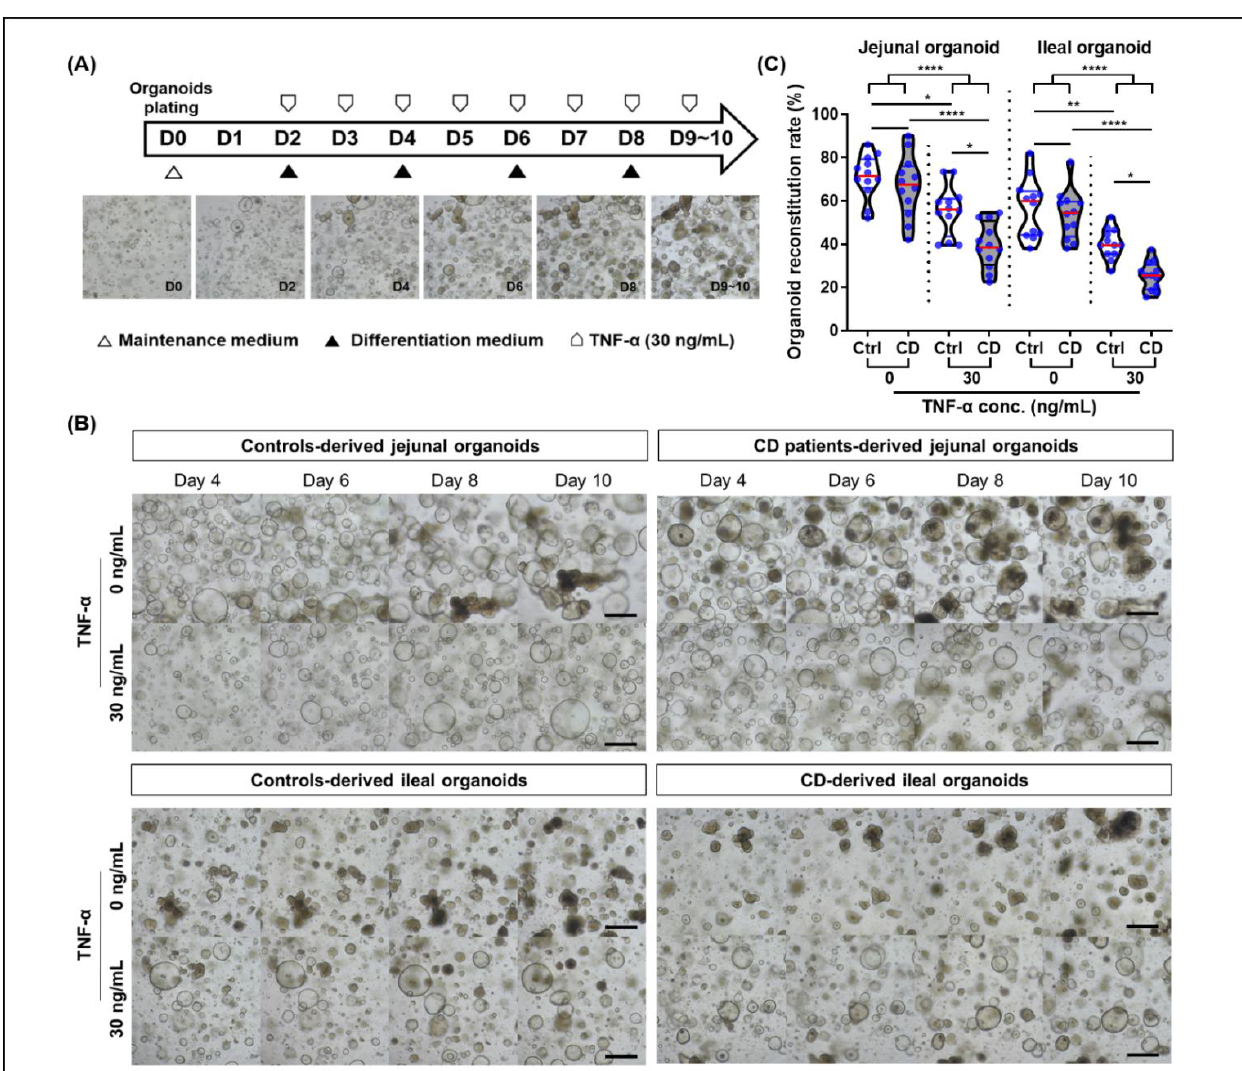
Figure 5. Organoid reconstitution assay in a tumor necrosis factor-alpha (TNFα) enriched condition. ( A ) Study flow diagram. ( B ) Organoid reconstitution assay of jejunal and ileal organoids derived from controls and CD patients (n = 5 each) in a TNFα-enriched condition. Assays were conducted in triplicate. ( C ) Organoid reconstitution rate. Reconstituted organoid number is expressed as a percentage value, based on values of TNFα-free jejunal organoids derived from controls. Differences were evaluated using ANOVA with Bonferroni’s multiple comparison test; * p < 0.05, ** p < 0.01 and **** p < 0.0001.